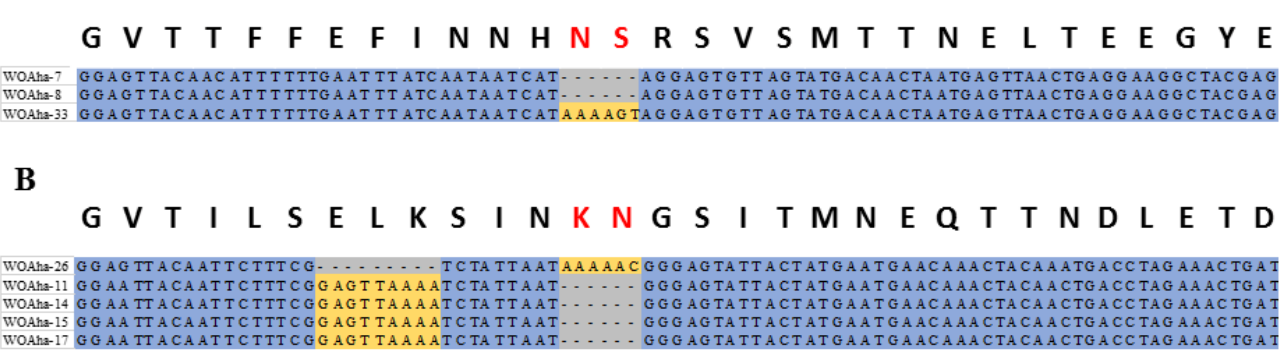
Figure 5. Maximum likelihood tree actively transcribed phage WO types of A. hakonensis based on orf7 sequences using WO-F; WO-R primers. WOS-Rx refers to the serial number. The numbers in parentheses indicate the number of sequences obtained. Phage WO types are shown on the right. Numbers above and below branches are bootstrap values computed from 1000 replications. 4. Discussion Although bacteriophages are typically thought to be rare or absent in obligate intra- cellular bacteria [35,36], phage WO is widely distributed in a variety of Wolbachia -infected insect groups [13,14,27,37–40]. Moreover, multiple phage infections ( Wolbachia strains con- taining more than one phage type) can be found in several Wolbachia strains [14,40]. Our phylogeny results reveal a high level of phage WO diversity in A. hakonensis and show that phage WO can be divided into four groups [16]. Phylogeny results based on WO-TF and WO-TR show that most of the genotypes were undetectable using the original